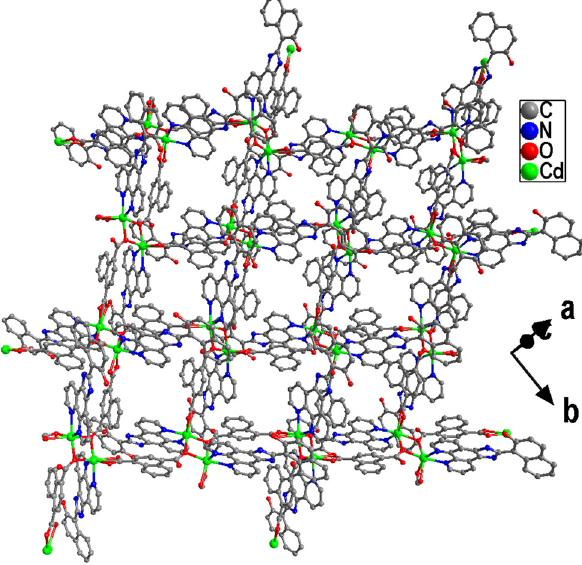
Figure 3: View of the 2D layer structure of 1 constructed by the 1,4 - NDC and L ligands.